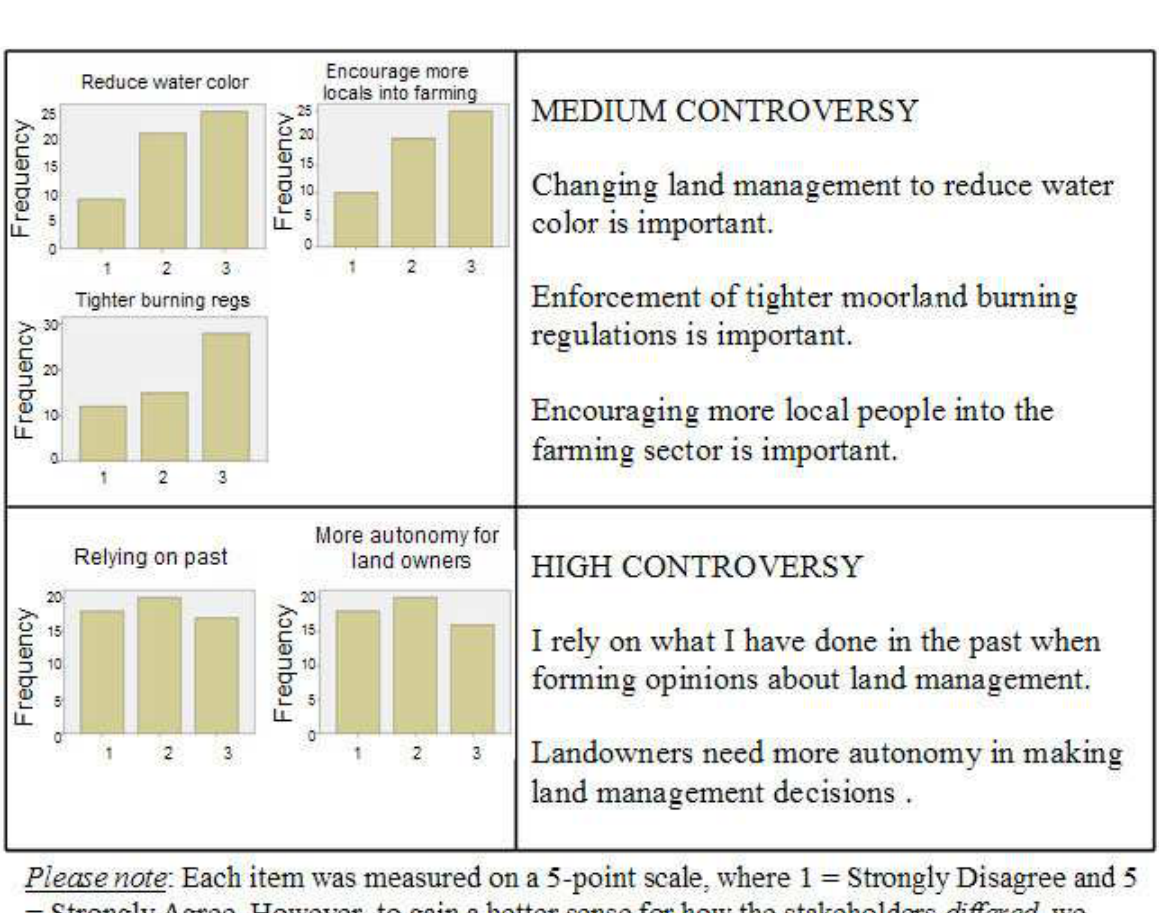
Fig. 2. Controversial views of land